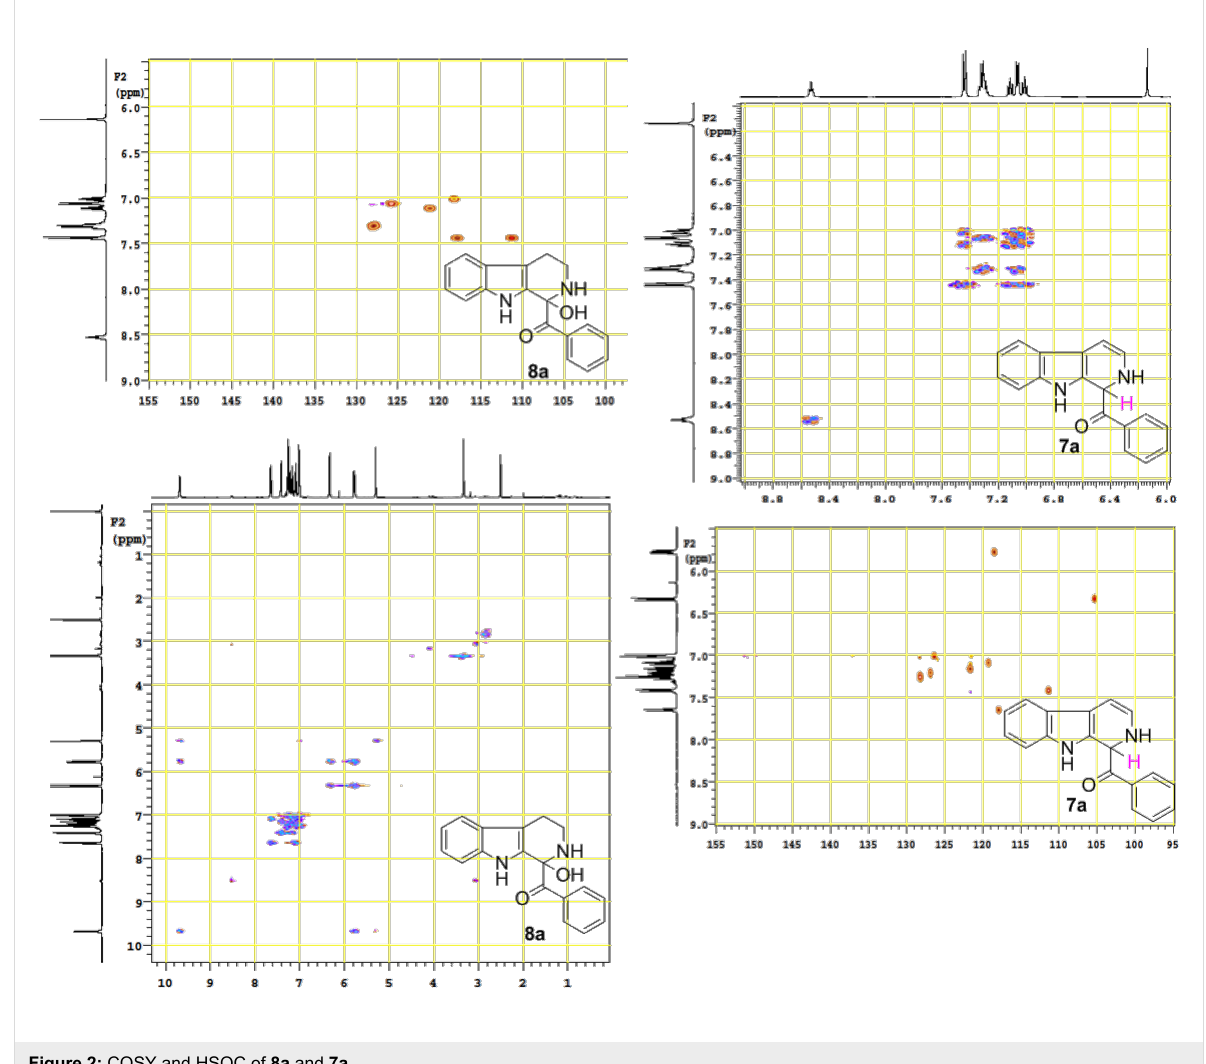
Figure 2: COSY and HSQC of 8a and 7a